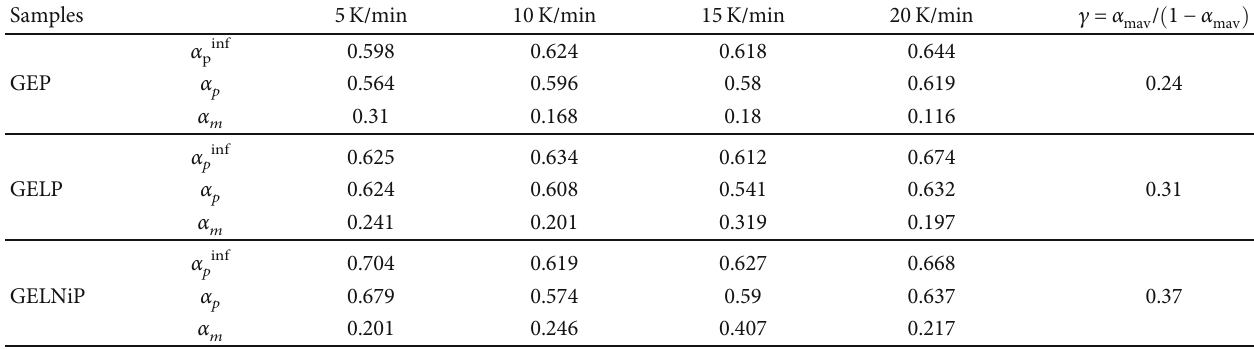
inf obtained from DSC analysis based on the Malek model at various heating rates. , α , and α p m p